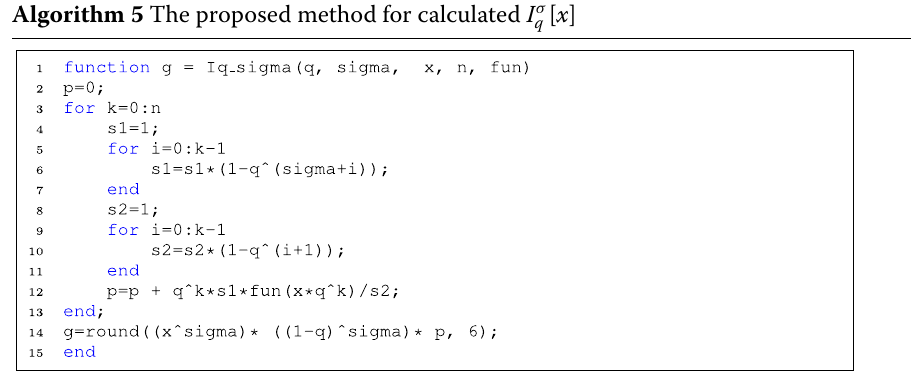
Algorithm 5 The proposed method for calculated I σ